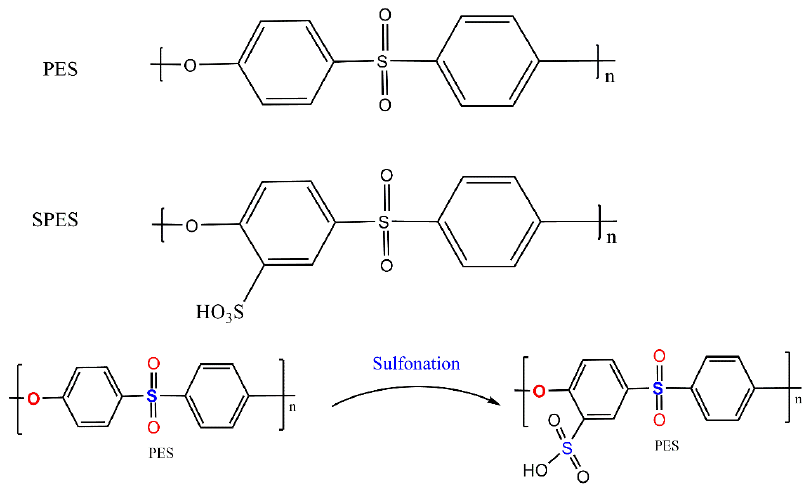
Figure 1. Polyethersulfone (PES) structure and sulfonated polyethersulfone (SPES) chemical structure after sulfonation.